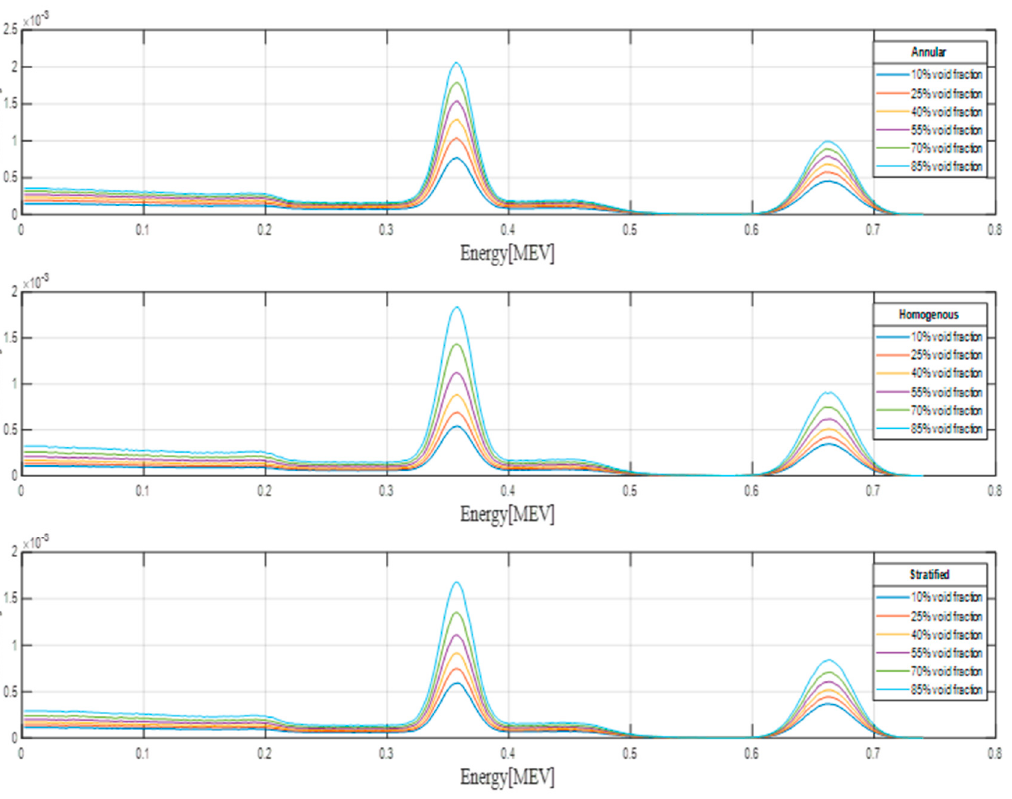
Figure 4. Recorded signal by the detector for all three simulated regimes at a 1-cm scale thickness in different void fractions.